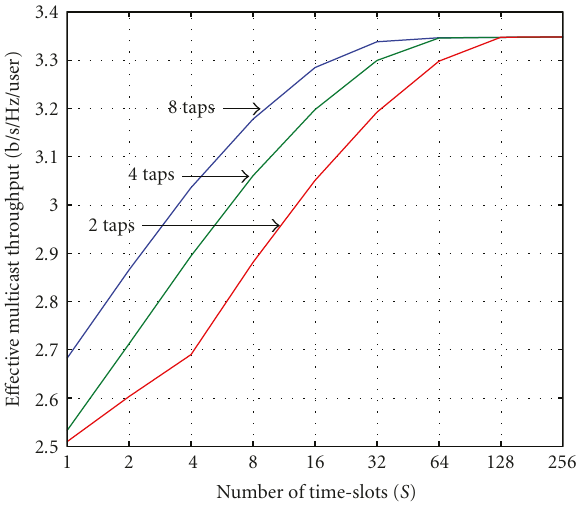
Figure 14: Performance of EECOMP for di ff erent numbers of timeslots in multipath fading channel with average SNR of